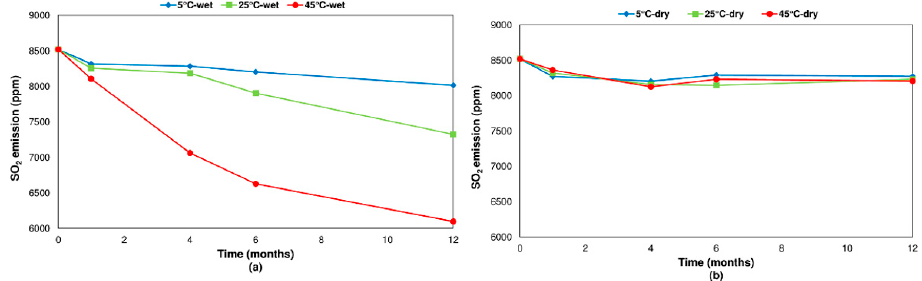
Figure 8. Sulfur dioxide emission area of pyrite (the fine fraction) at 200–600 ° C in ( a ) a wet environment and ( b ) a dry environment .